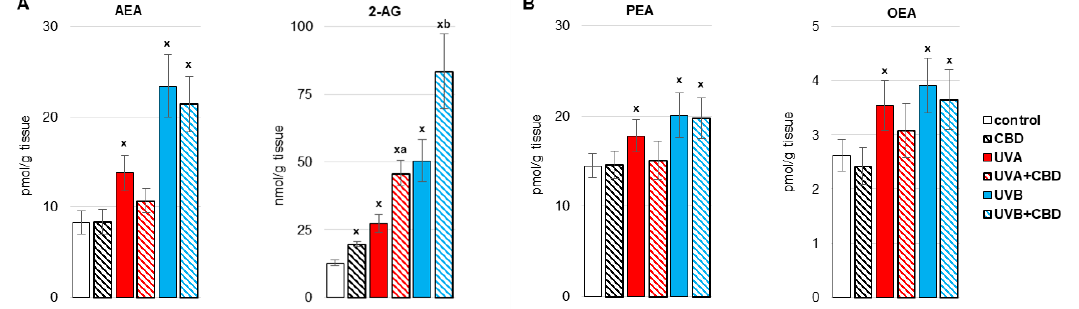
Figure 6. The level of pro-inflammatory eicosanoids (prostaglandin E2 (PGE2), leukotriene B4 (LTB4)) ( A ) and anti-inflammatory eicosanoids (15-deoxy-delta12,14-prostaglandin J2 (15d-PGJ2), 15-hydroxyeicosatetraenoic acid (15-HETE)) ( B ) in the liver of nude rats in the following groups: treated with CBD (every 12 h) for 4 weeks; irradiated with UVA (every 48 h) and treated with CBD (every 12 h) for 4 weeks; irradiated with UVB (every 48 h) and treated with CBD (every 12 h) for 4 weeks. The mean values for six rats in each group ± SD are shown: x — differences vs. control group, p < 0.05; a — differences vs. UVA treated group, p < 0.05; b — differences vs. UVB treated group, p < 0.05.